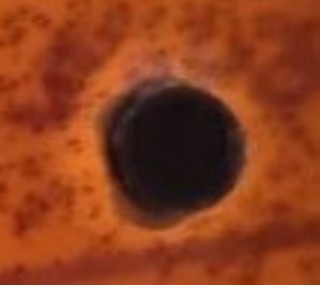
Figure 4. Inhibition zone of S. mutans bacteria for GIC contained CuO NPs. Table 2. Diameter of inhibition zone of S. mutans bacteria for GIC in in different weight percentages of CuO NPs.